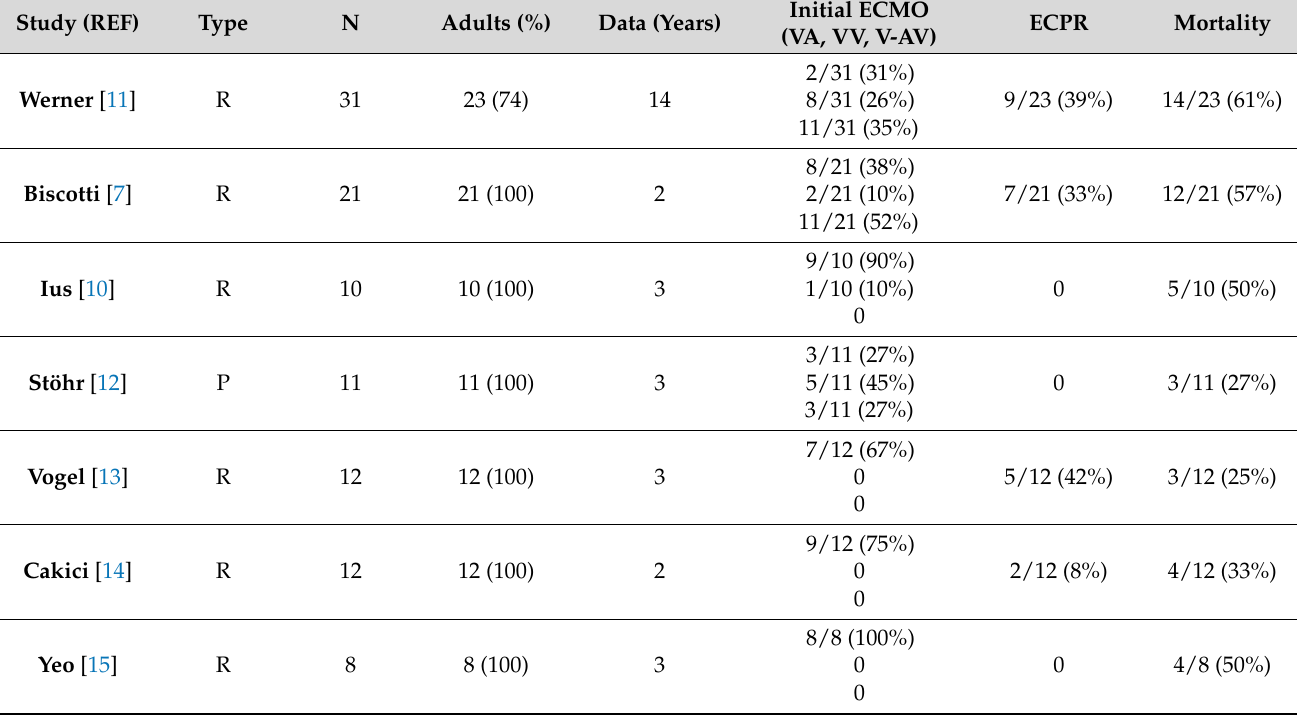
Table 4. Summary of studies reporting the use of veno-arteriovenous extracorporeal membrane oxygenation on adult